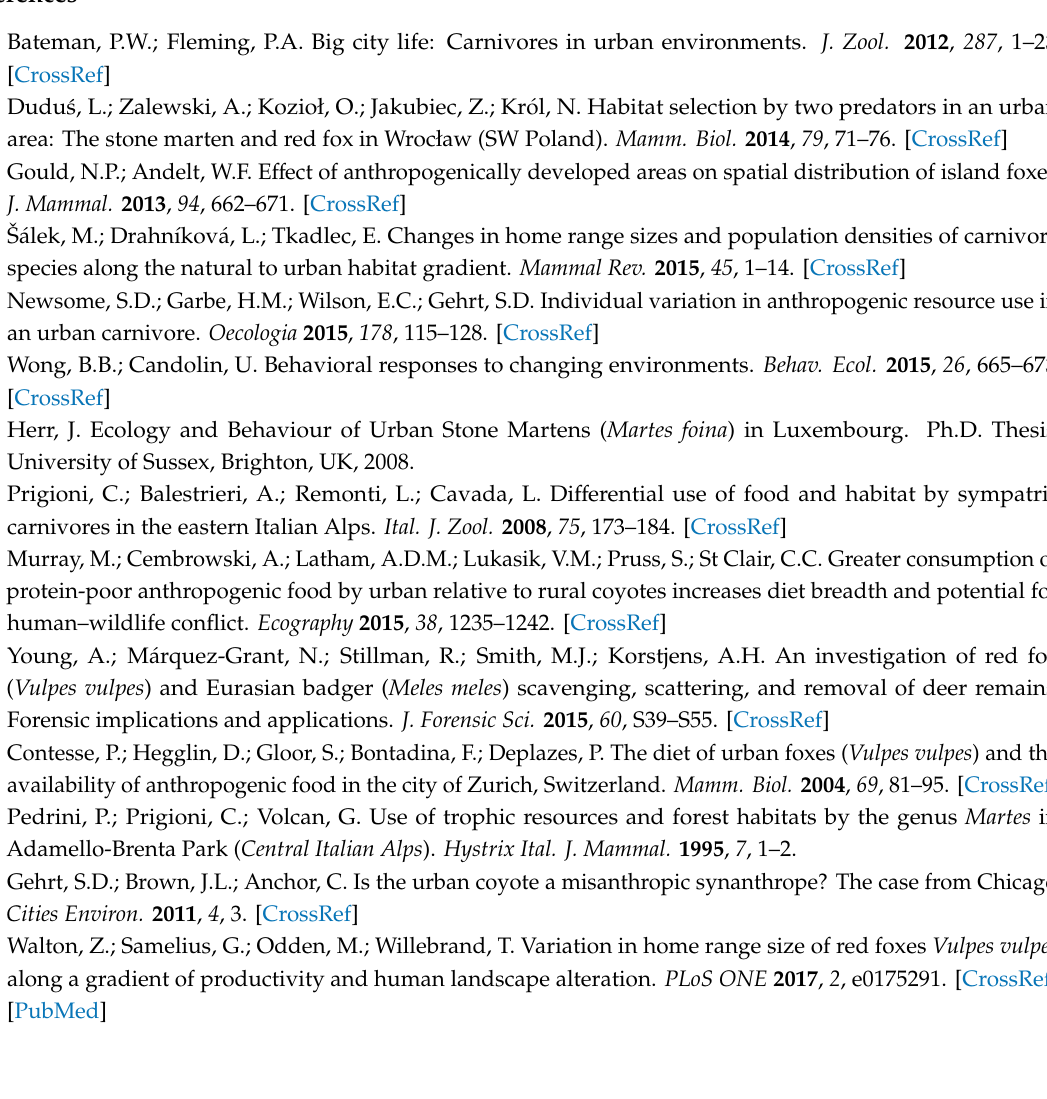
Table S5: Seasonal home range sizes, based on two estimates (MCP and KDE), of female (f) and male (m) yellow mongooses in the Meyersdal estate, Table S6: Seasonal percentage of total GPS locations ( n = number of GPS locations) overlapping with human residential gardens, of female (f) and male (m) yellow mongooses in the Meyersdal